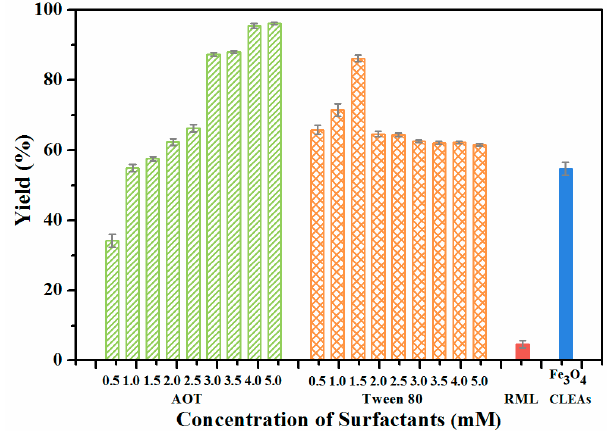
Figure 9. Effect of activation of different surfactants on activity of magnetic RML CLEAs.